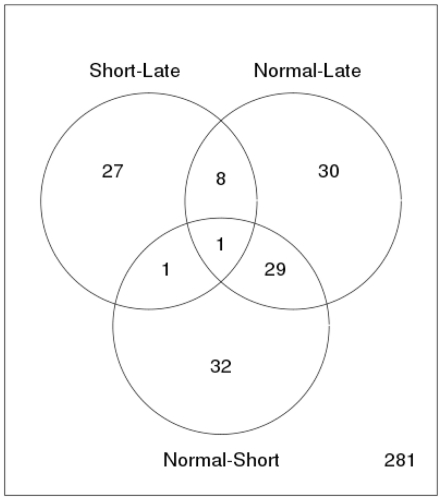
Comparison of survival groups of NSCLC patients.The Venn diagram shows the number of all differentially expressed miRNAs across different comparisons: Tissue from NSCLC patients with short survival versus tissue from NSCLC patients with long survival, tissue from normal lung versus tissue from NSCLC patients with long survival and tissue from normal lung versus tissue from NSCLC patients with short survival. Out of 281 miRs evaluated, the number of differential expressed miRs with FDR adjusted P<0.1 (total n = 128) of each comparison is indicated.